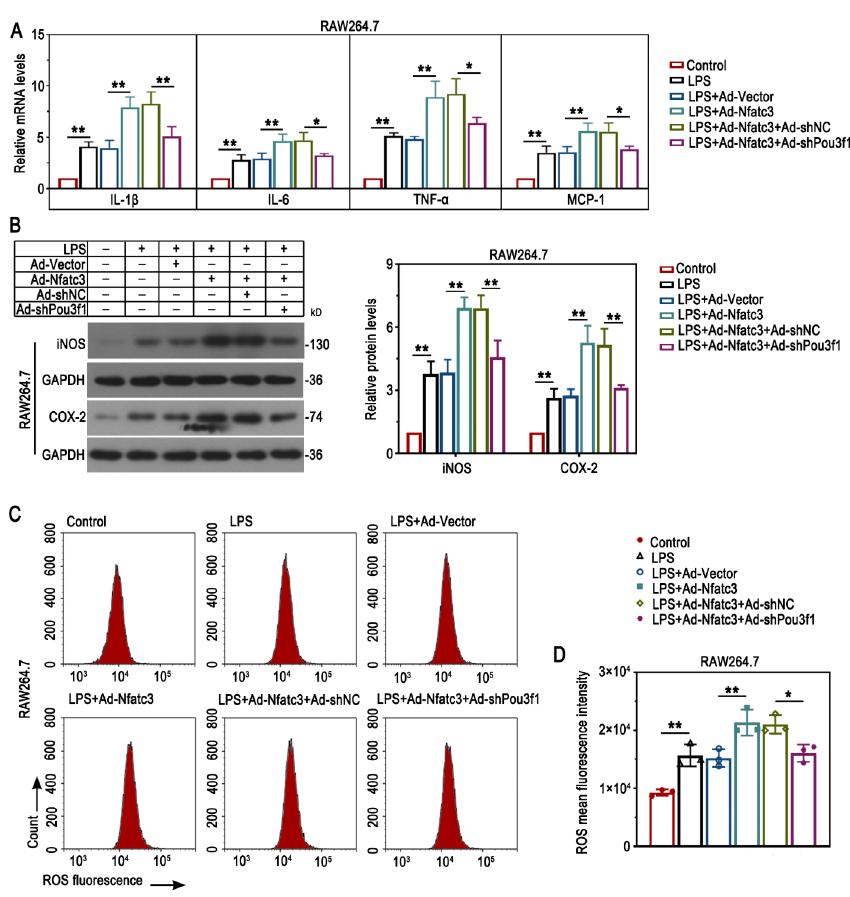
Fig. 4 Pou3f1 was required for Nfatc3-induced inflammation in LPS-treated macrophages. (A) The relative mRNA levels of IL-1β, IL-6, TNF-α and MCP-1 were determined by qPCR. (B) The protein levels of iNOS and COX-2 were detected using Western blot. (C-D) Flow cytometry analysis and quantification results for the fluorescence intensity of ROS. n = 3. Values were mean ± SD. *, p < 0.05; **, p < Pou3f1 knockdown affected cell proliferation and death in colon tumors of UC-CRC mice The epithelial inflammation is an essential initiator of tumorigenesis in UC-CRC. The expression of PCNA in colon epithelium of UC-CRC mice was inhibited by Pou3f1 increase of TUNEL-positive cells in colon epithelium of UC-CRC mice. These findings